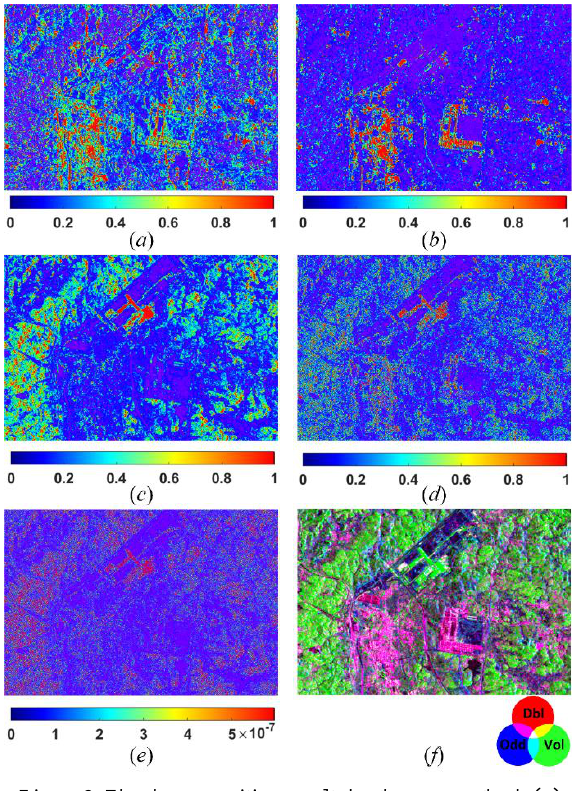
Figure 2. The decomposition results by the new method. ( a ) Odd-bounce scattering; ( b ) Double-bounce scattering; ( c ) Volume scattering; ( d ) Helix scattering; ( e ) Diffuse scattering; ( f ) RGB image color coded by red: double-bounce (Dbl), green: volume scattering (Vol), blue: odd-bounce